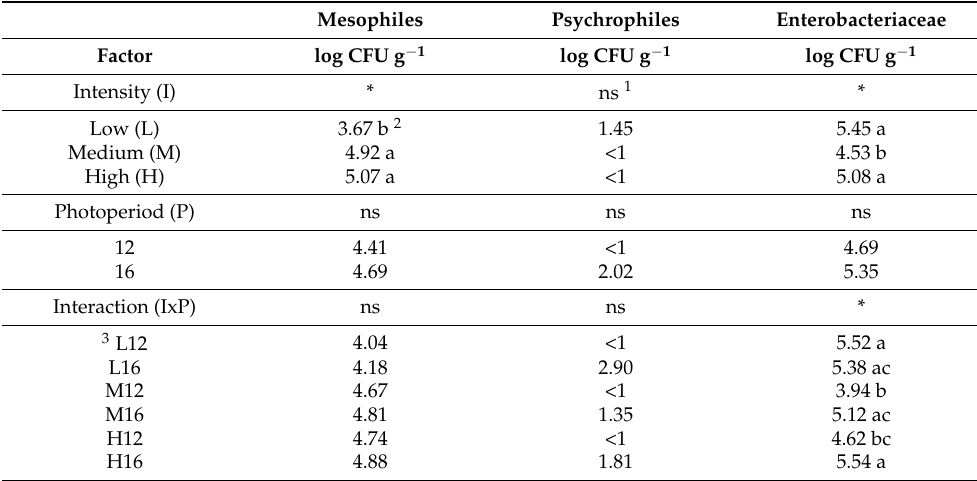
Table 4. Microbiological bacterial counts (log CFU g − 1 ) of beet microgreens under different light treatments. Values are the mean of 3 repetitions.